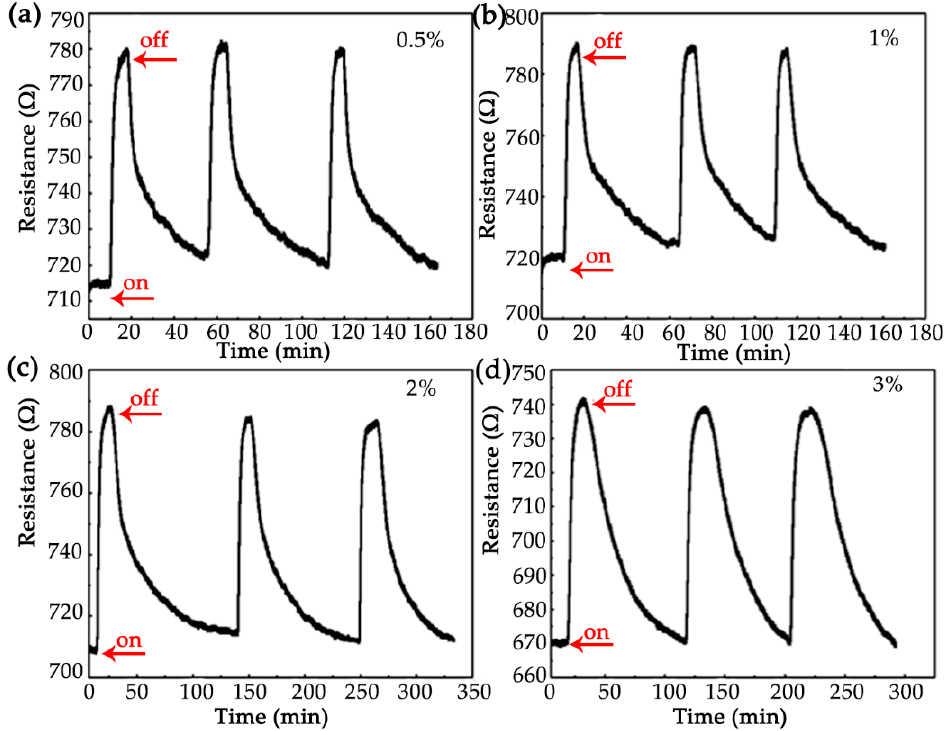
Figure 5. Cyclic response of the sensor at different hydrogen concentrations ( a ) 0.5%; ( b ) 1%; ( c ) 2% and ( d ) 3%.